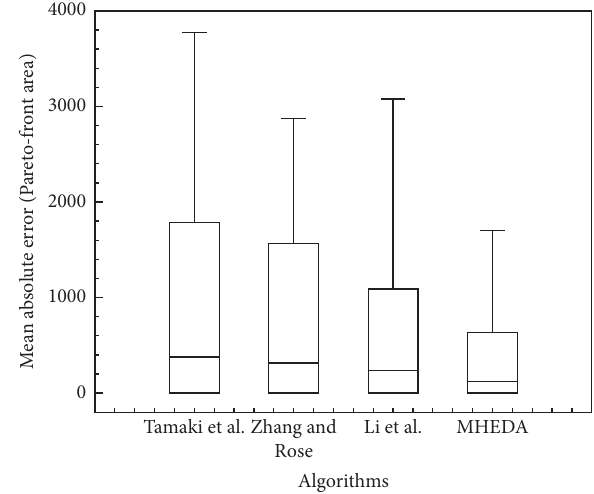
Figure 12: Comparison results for the MHSP using the mean square error.